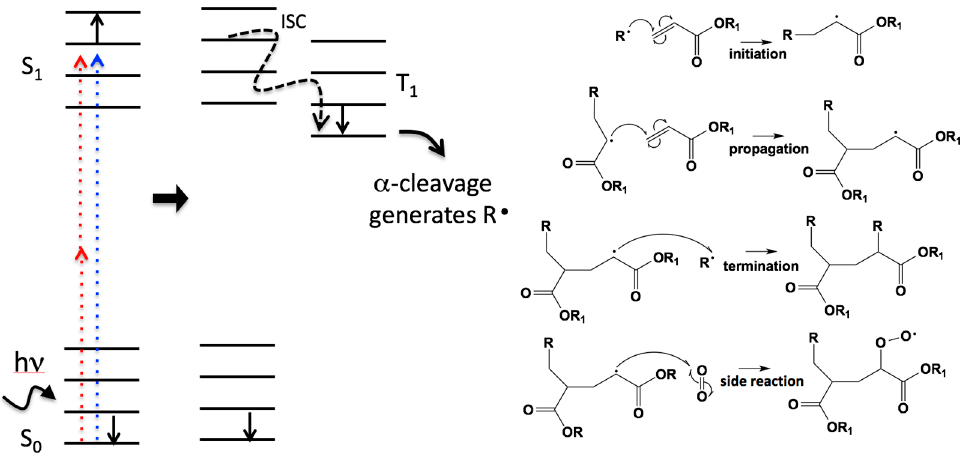
Figure 1. On the left is shown a Jablonski diagram where an electron in the photoinitiator can become excited from the ground state, S 0 , to an excited state, S 1 , either by absorbing ultraviolet (UV) light or two photons of near-infrared (NIR) light. The excited electron relaxes and flips its spin by internal conversion (IC), and flips its spin by intersystem crossing (ISC), and goes to an excited triplet state, T 1 . From T 1 the molecule can undergo α -cleavage to generate radicals, which then begins the polymerization reaction shown on the right. Notably, the last side reaction listed is possible if the resin contains dissolved O 2 . This reaction with O 2 yields a less labile peroxy radical and effectively quenches the polymerization reaction [19].